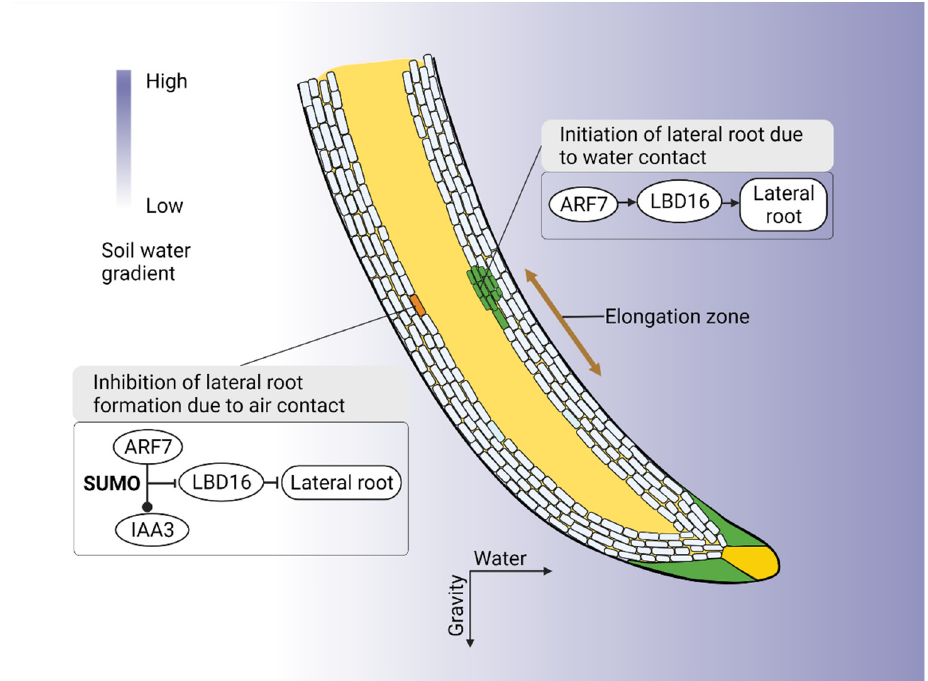
Figure 3. Molecular mechanism of root hydrotropism and hydropatterning. ARF7 is crucial for preferential lateral root branching towards water (hydropatterning). ARF7 regulates LBD16 which initiates lateral root formation towards the water. On the dry side of the soil, SUMO protein enables ARF7 to increase auxin repressor protein IAA3. IAA3 represses LBD16 ; thus, no lateral root formation [18,87]. In response to a water gradient, ABA mediates differential growth response. In the root elongation zone cortex, ABA signaling kinase SnRK2.2 and MIZ1 are expressed that inhibit hydrotropism by preventing cell elongation.